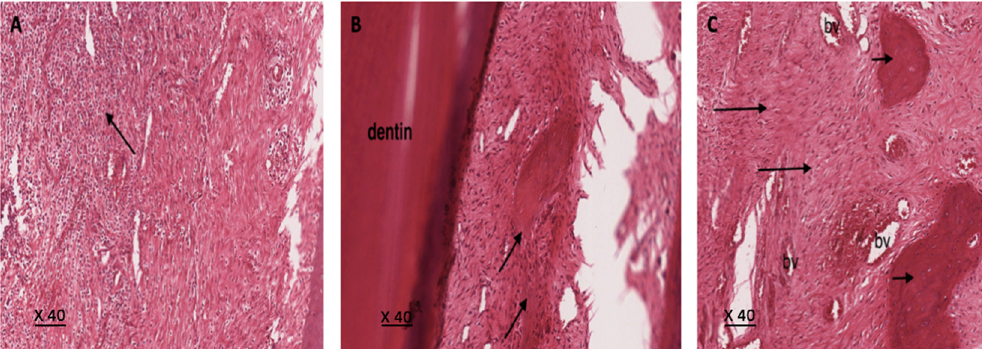
Figure 3. Histological section of furcal perforation at 1 month repaired with ( A ) CollaCote showing intense lymphocytic inflammatory infiltrate (arrow), ( B ) Chitosan scaffold showing inflammatory infiltrate with bone formation (arrows), ( C ) Chitosan with Simvastatin scaffold showing fibroblastic tissue (long arrows) with prominent vascularity (bv) and bone formation (short arrows). H&E stain × 40 magnification.